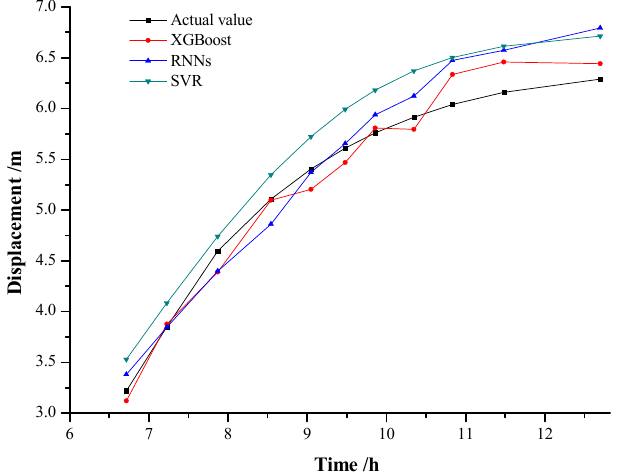
Figure 8. Variation of displacement predicted values of D6 with time.